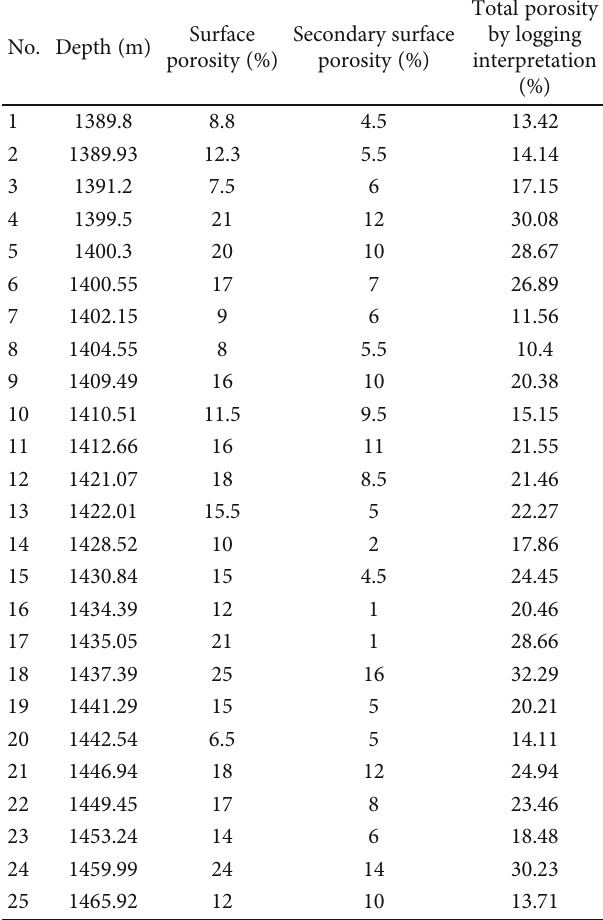
Total porosity by